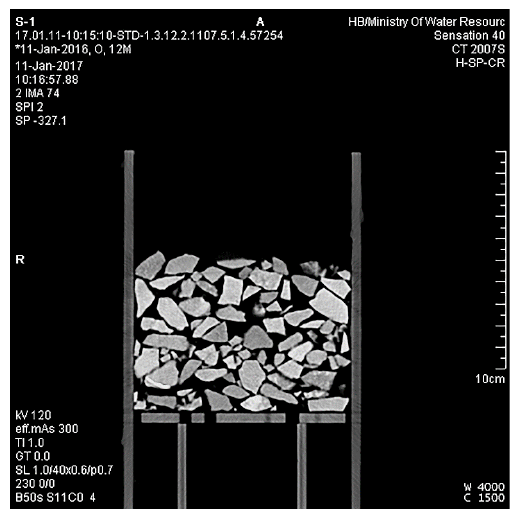
Figure 4. A CT image of S1.